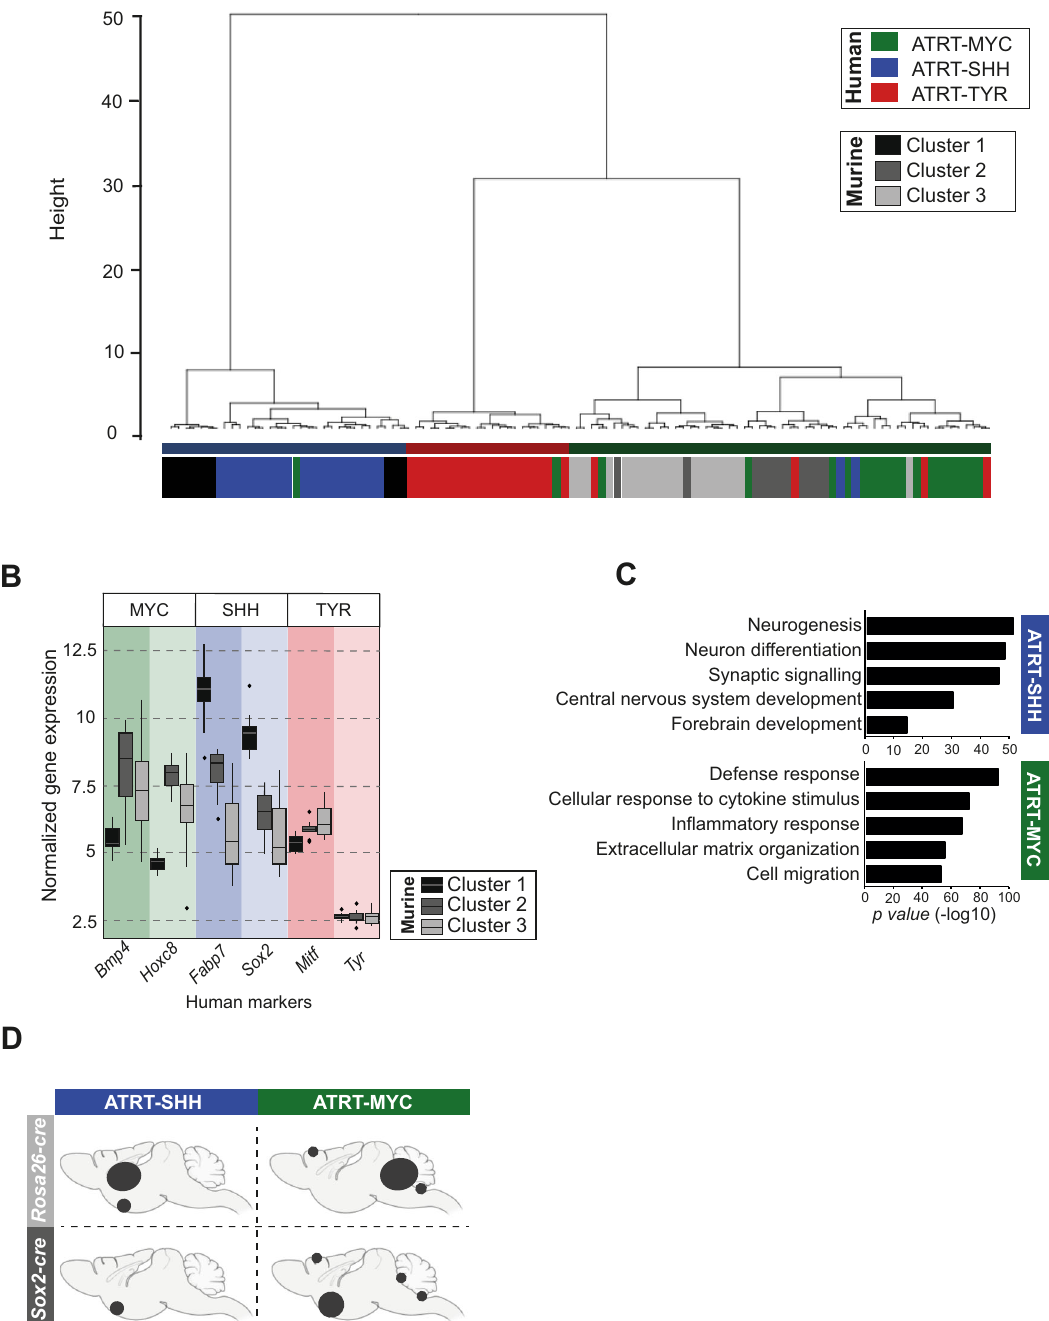
a score of similarity between the given reference cell type and the tumor cells. We only considered tumor cells (neglecting stroma cells) and performed individual analysis per subtype. Strikingly, we obtained mid/hindbrain progenitor cells as most similar embryonic cell type for ATRT-SHH tumor cells, whereas pri- mordial germ cells (PGCs) emerged as the cell type with the highest similarity score for ATRT-MYC (MYC IC-RT and MYC spinal tumors) and eRT (Fig. 4A, Supplementary Fig. 8). Func- tional gene network analysis revealed that subsets of genes that are found by the logistic functions as predictor genes are tightly connected (Supplementary Fig. 9A, B). Focusing on